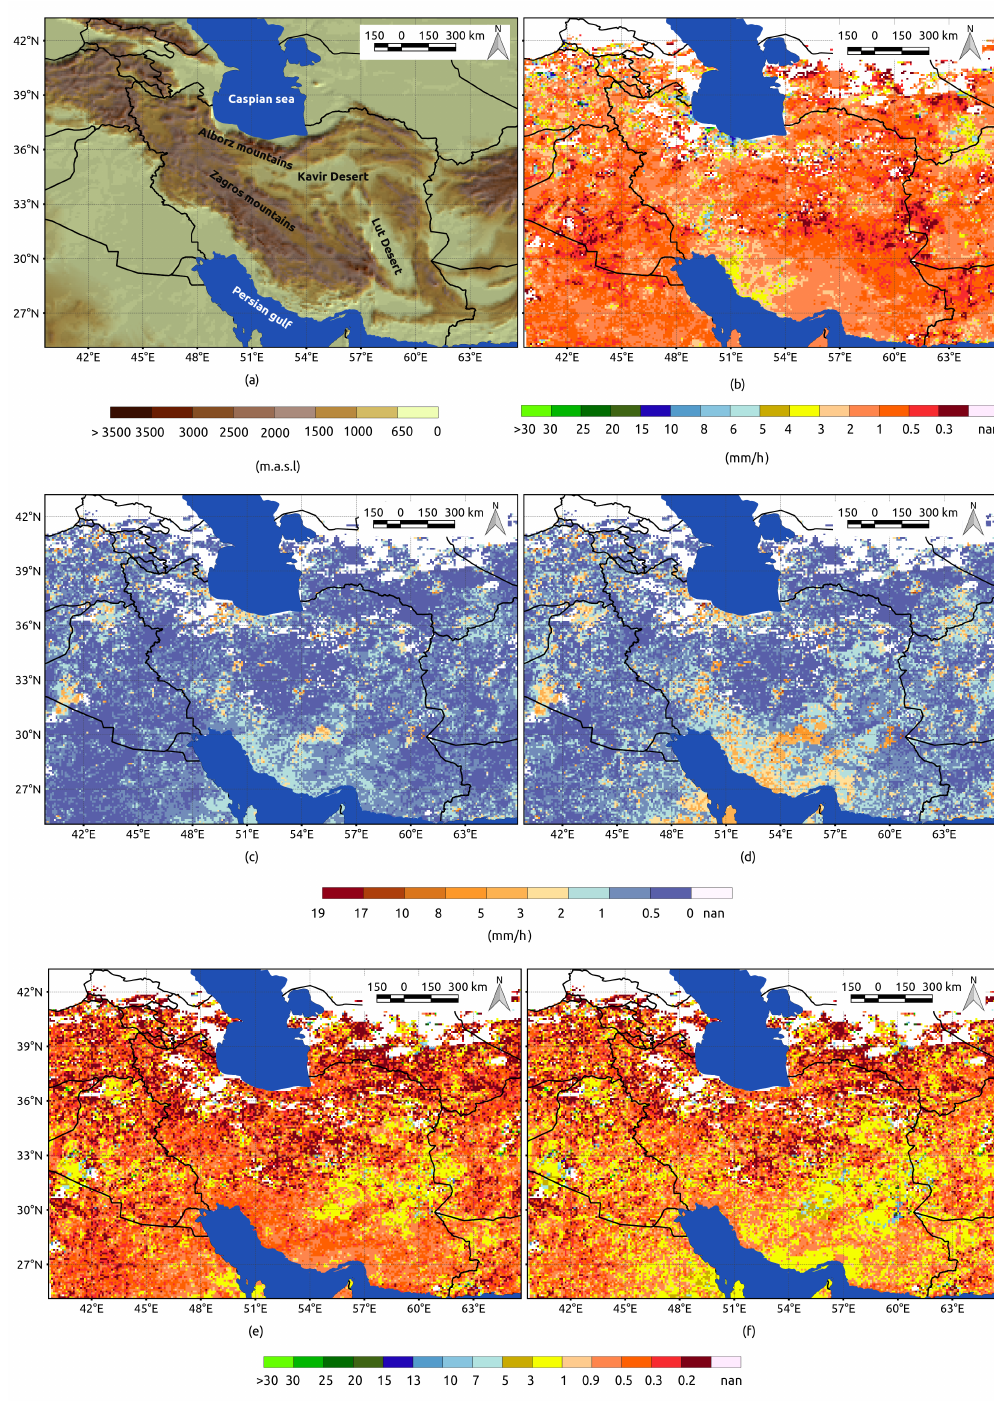
Figure 13. Spatial distribution of ( a ) elevation; ( b ) average rainfall rate; ( c ) average MAE; ( d ) average RMSE; ( e ) average MAE to average rainfall rate (MAE rate); and ( f ) average RMSE to average rainfall rate (RMSE